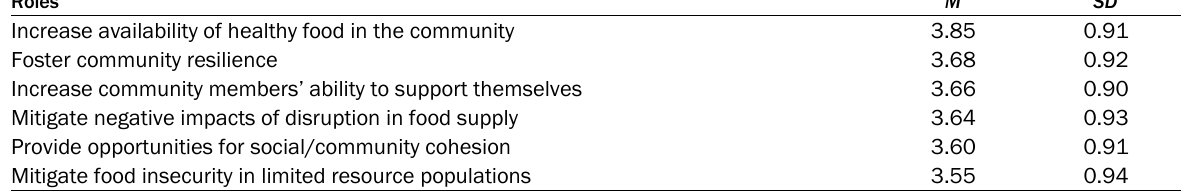
Table 11. Role of Local Food Production in Public Health Emergencies ( n= 87) Roles